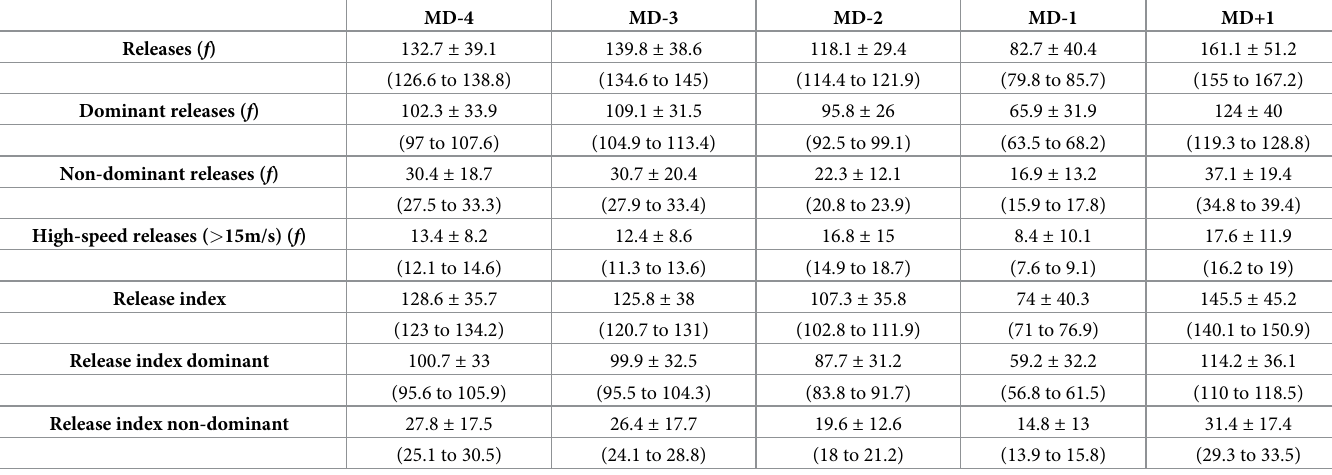
Table 1. Estimated marginal means ( ± SE) and 95% confidence interval values representative of the absolute frequency of ball releases, dominant ball releases, non- dominate ball releases, high-speed ball releases, ball release index, ball release index dominant and ball release index non-dominant for professional soccer players according to match proximity (match day